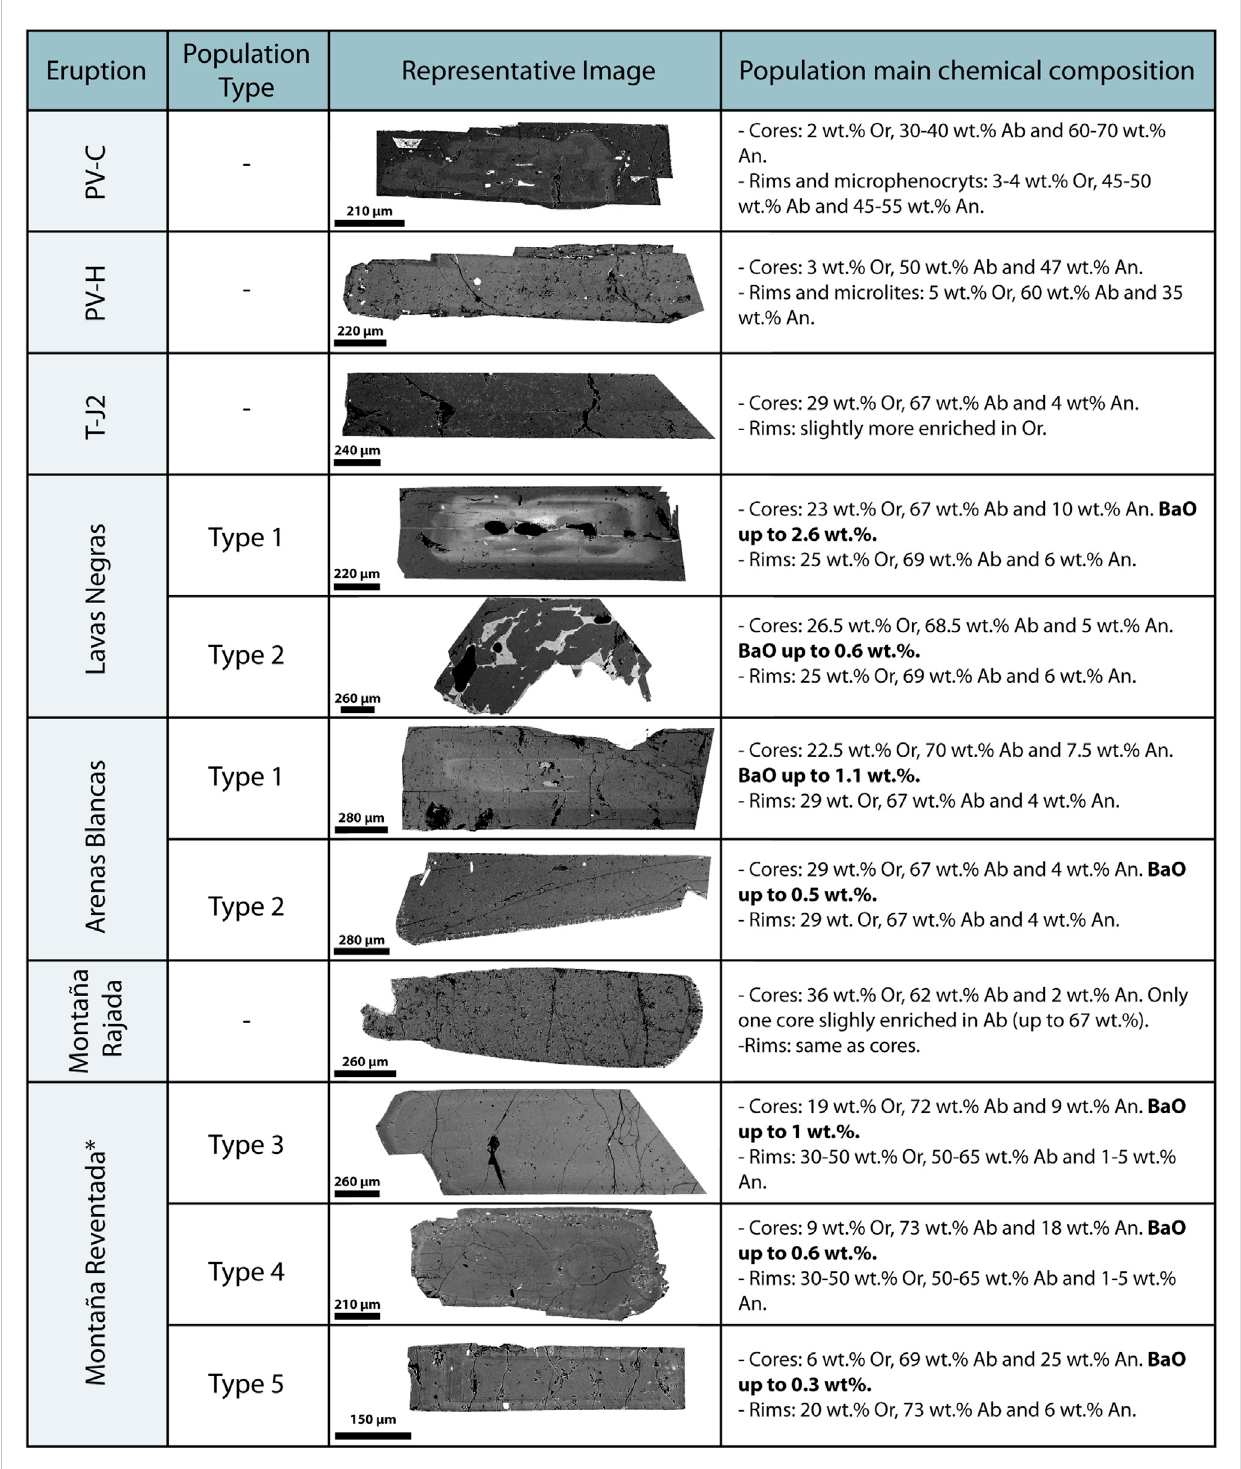
FIGURE 10 Table illustrating the population of feldspar phenocrysts found in Teide-Pico Viejo samples. *Type 4 and 5 cores in Montaña Reventada grade into compositions similar to Type 3 cores towards the outer part of the mineral. See text and Figure 9.